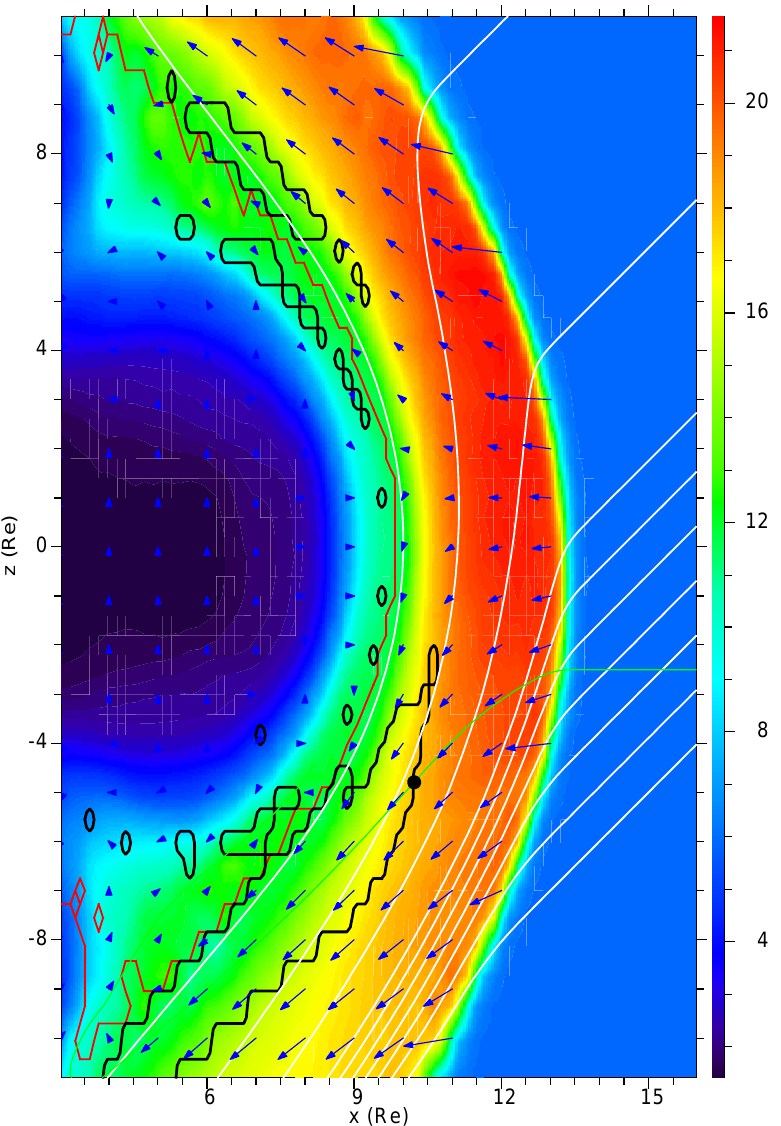
Fig. 13. The slow mode fronts in the magnetosheath in the GSE y=0 plane for Run 3 with tilted IMF. The plasma density is shown as the background, the open-closed magnetic field boundary is shown as a red zigzag curve, magnetic field lines are shown as white smooth curves, and the blue arrows are the flow velocity. The slow mode fronts are shown as closed black zigzag curves (only the segments of the curves where plasma flows into the closed regions should be identified as the slow mode fronts). Some parameters along the green flow line which crosses the slow mode front are shown in Fig.